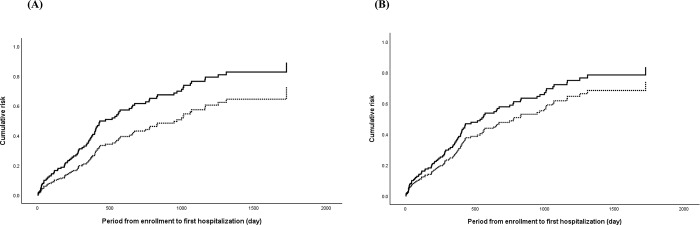
Cumulative risk of first hospitalization for patients with PIM use (solid line) and without PIM use (dotted line) according to the STOPP-J (A) and Beers Criteria (B).